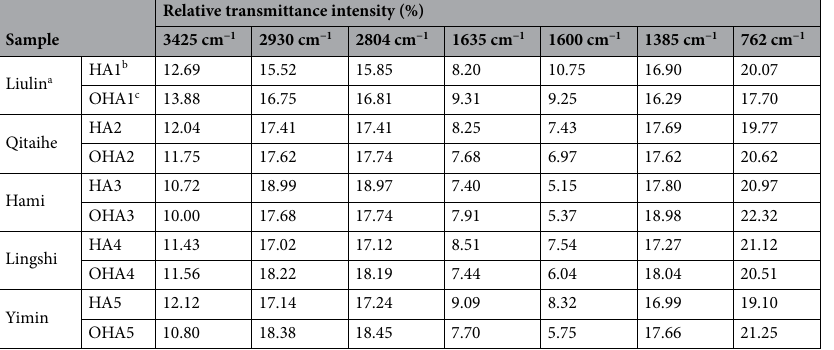
Table 2. Relative transmittance intensity of HAs revealed by FTIR spectra. a The location of coal. b The HAs extracted from original coal. c The HAs extracted from oxidized